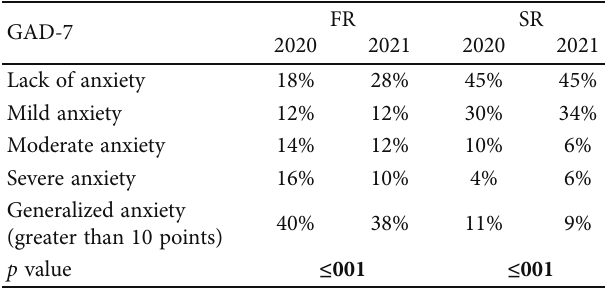
Table 2: GAD-7 results ( N = 300